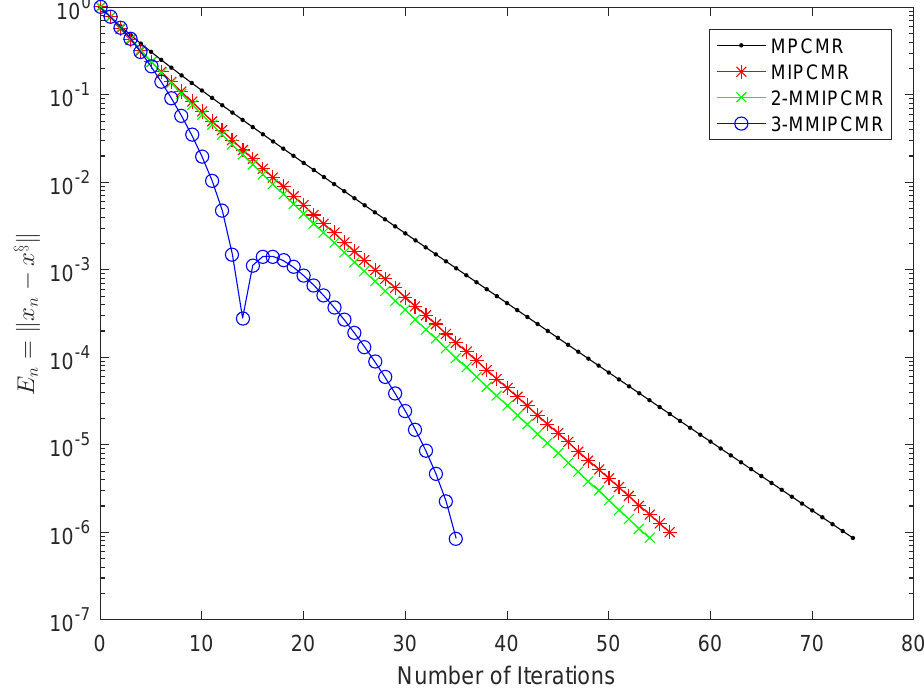
Figure 2. Comparison of MPCMR, MIPCMR, 2-MMIPCMR and 3-MMIPCMR in Example